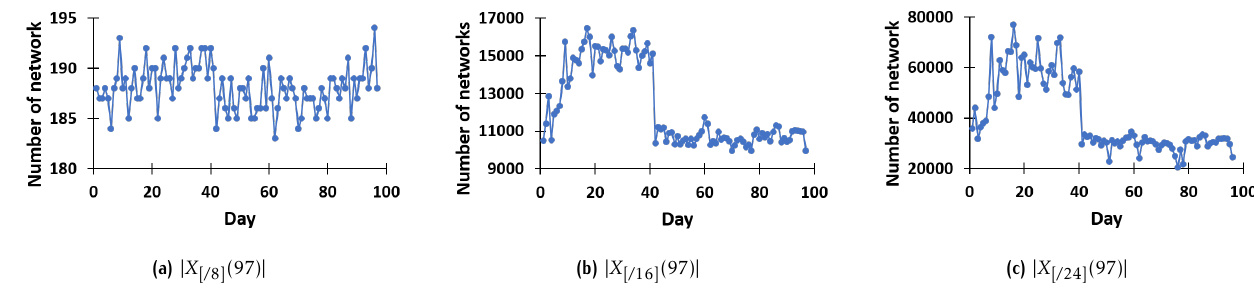
| (i.e., the number [ r ] (97)